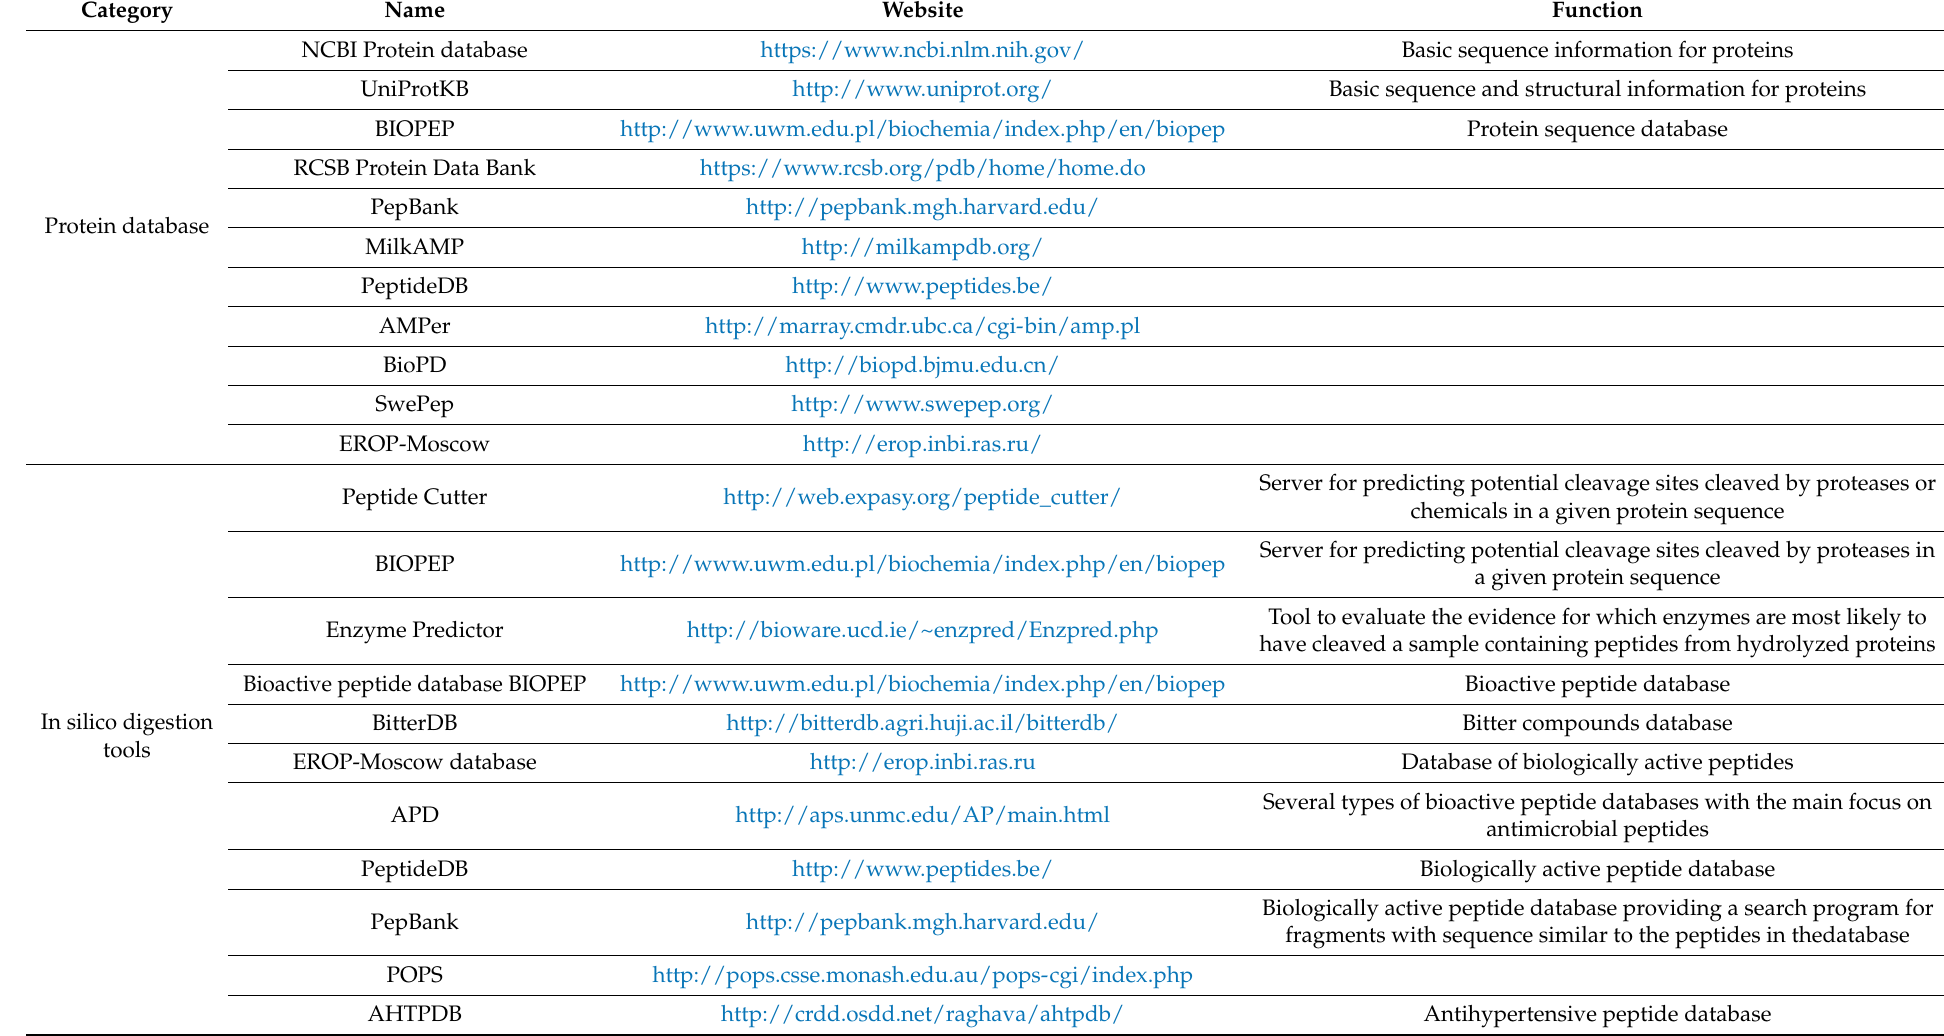
Table 4. Principal in silico methods include databases, online tools, and